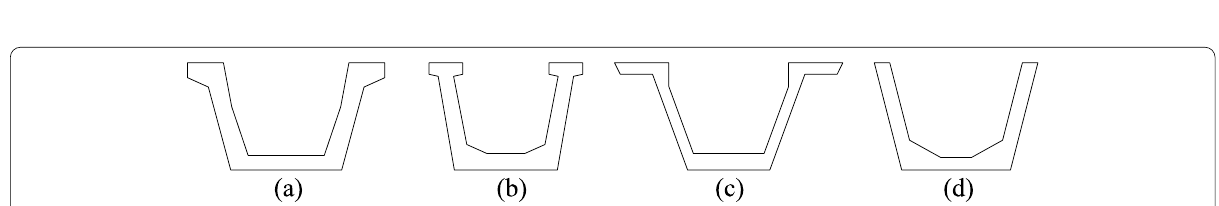
Fig. 2 Selected tub girder sections: a Texas U54; b Washington UF72G5; c Colorado B-618-U; d Washington trapezoidal